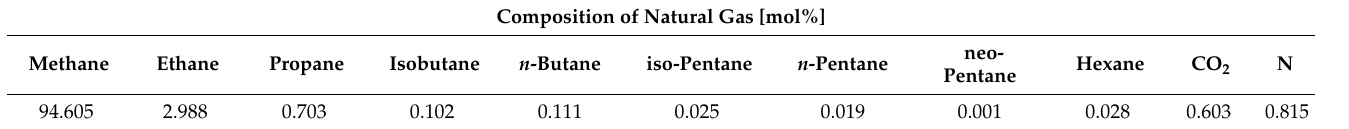
Table 1. Composition of natural gas.